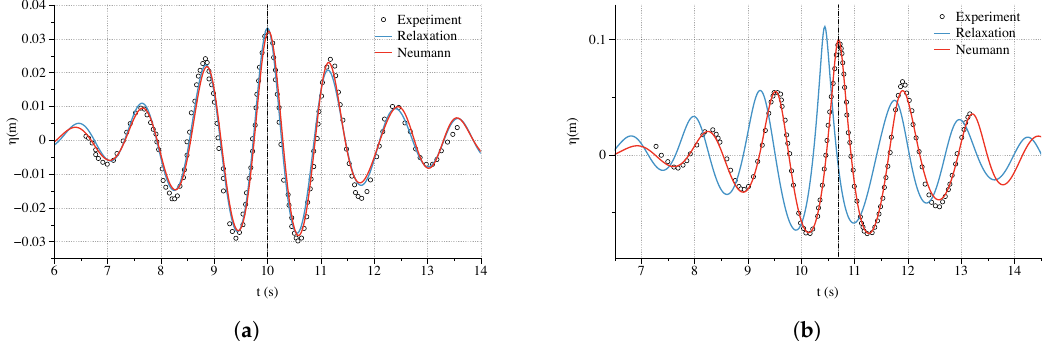
Figure 23. Comparison of the time series at the focusing location of 7.5 m generated by a relaxation method and a Neumann boundary, ( a ) for the simulation case NING1, ( b ) for the simulation case